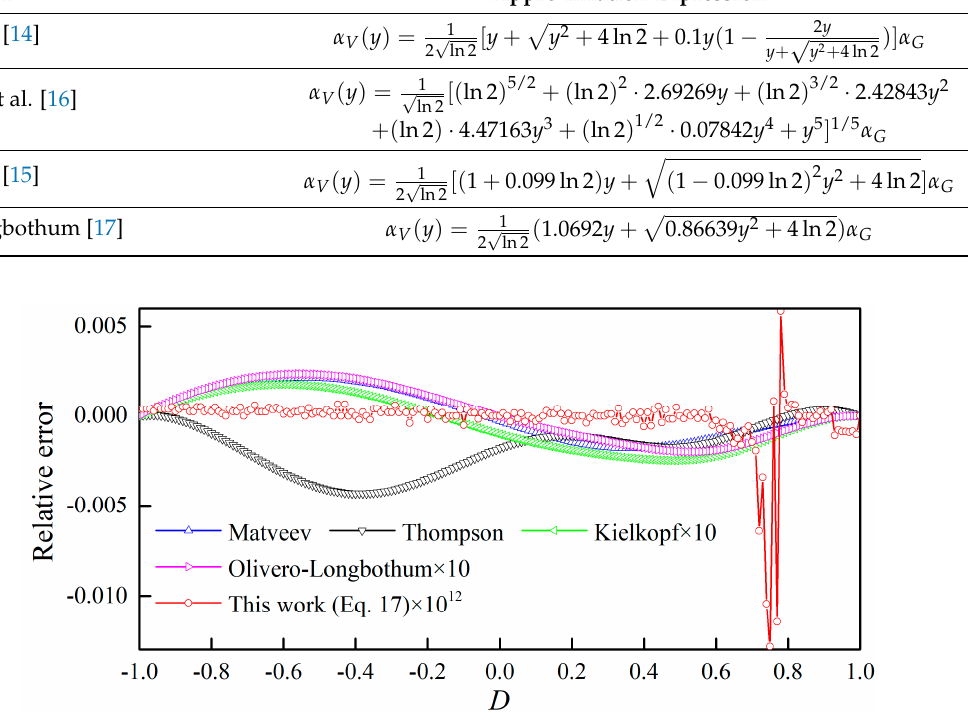
Figure 2. The relative errors of different approximation schemes on a double precision platform.